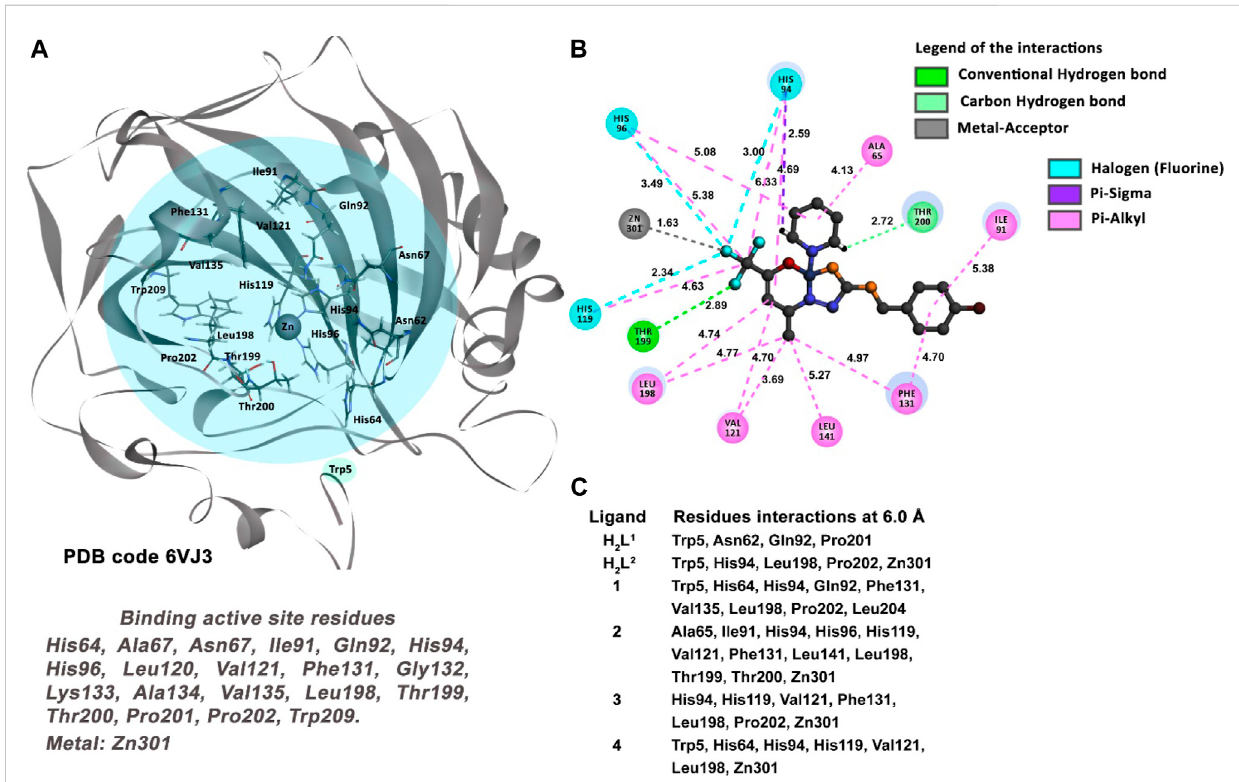
Molecular docking results of the MDA-MB-231 cell type target. (A) Binding active site regions of the CA protein ( 6VJ3 ) (Petreni et al., 2020). (B) 2D representation of the interactions carried out between the best-ranked inhibitor, 2, and the residues of the active site of the receptor. (C) Main nearest residues of both active sites of the 6VJ3 receptor (distance till 6.0 Å) and all the six compounds